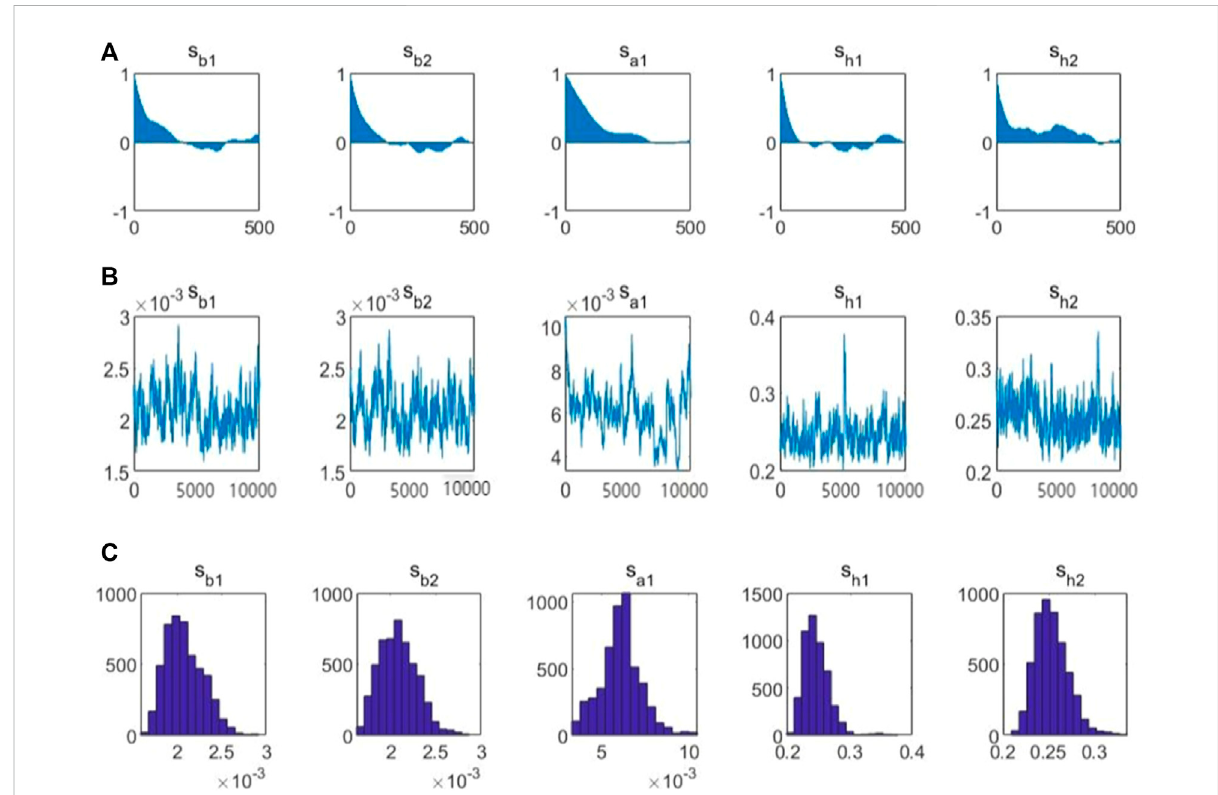
FIGURE 6 Graph of parameter estimation results. (A) The autocorrelation coef fi cient of sampling, (B) dynamic path, and (C) posterior distribution graph.